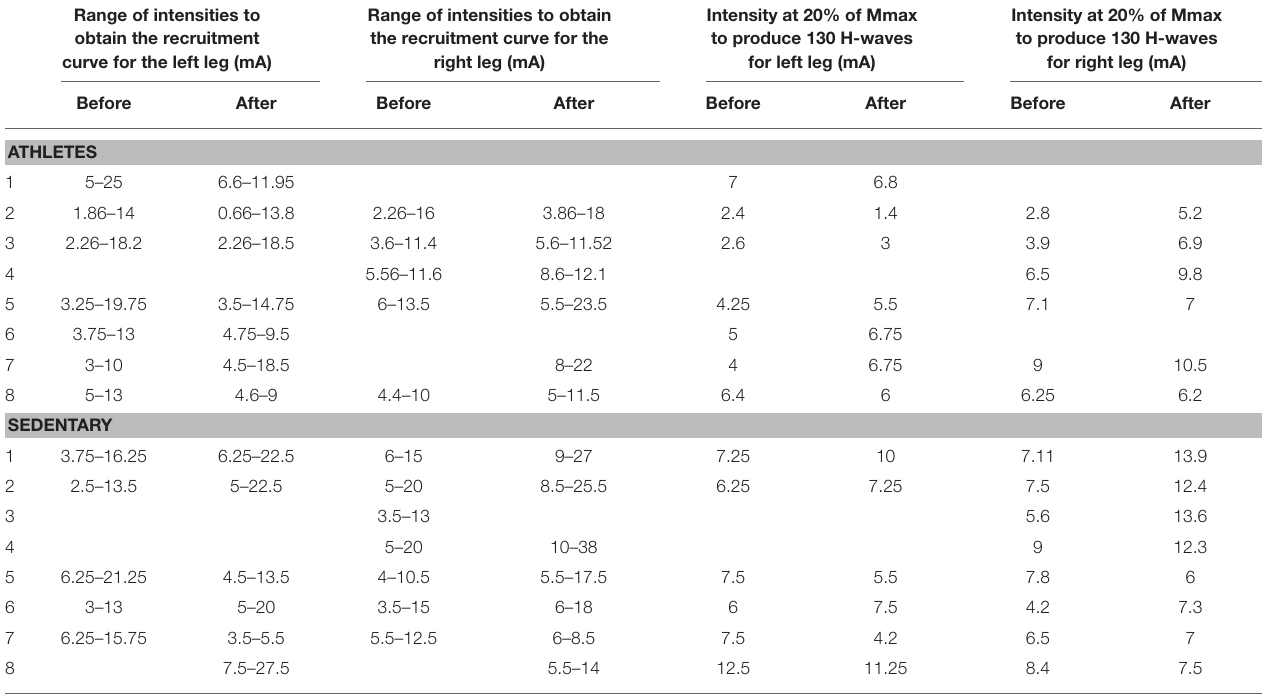
TABLE 2 | Range of stimulation intensities employed for the recruitment curves and the intensity at 20% of Mmax. Range of intensities to obtain the recruitment curve for the left leg (mA)